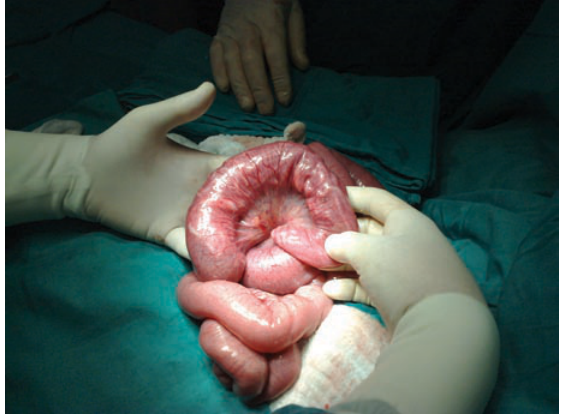
Figure 2. Intraoperative photograph of multiple Ascaris lumbricoides worms seen through the bowel